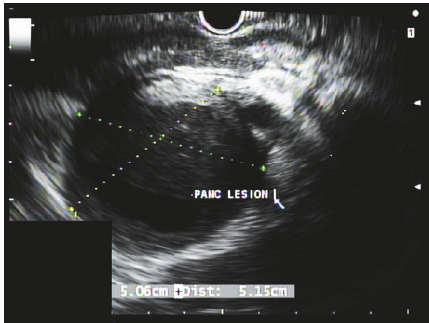
Figure 3: EUS image; pancreatic tail lesion with anechoic compo- nent.